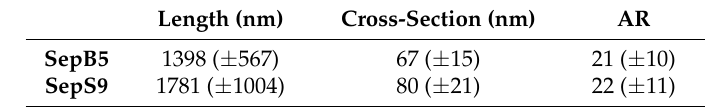
Table 1. Dimensions * and AR of SepX fibers, obtained by scanning electron microscopy